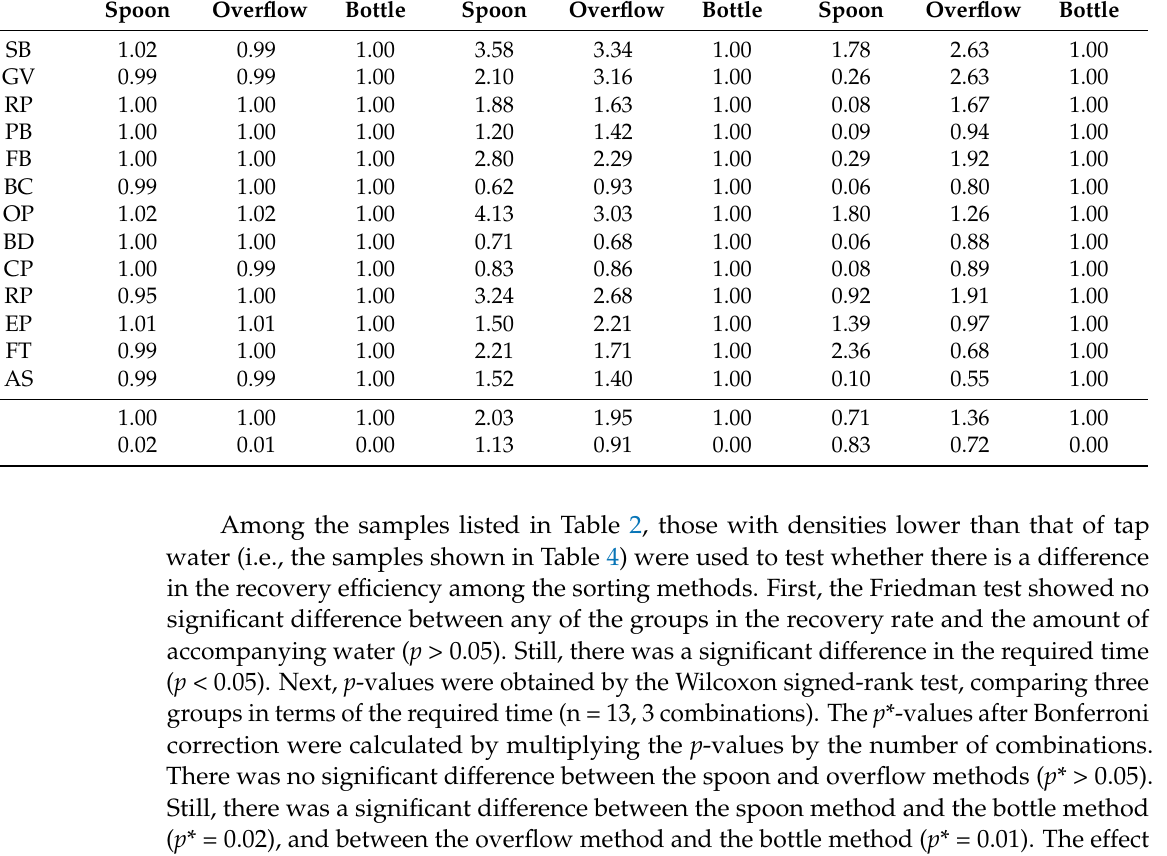
Table 4. Ratios of recovery efficiencies (recovery rate, required time, and amount of accompanying water) of the spoon method and the overflow method to that of the bottle method (n = 6). Recovery Time Accompanying Water Spoon Overflow Bottle Spoon Overflow Bottle Spoon Overflow Bottle 0.99